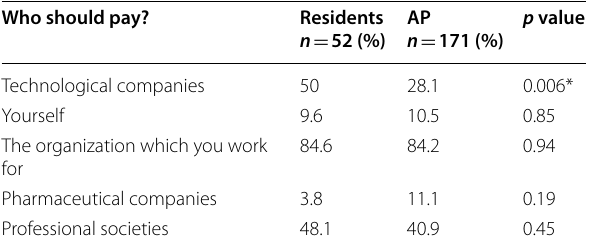
Table 4 Chi‑square analysis of cost of training section